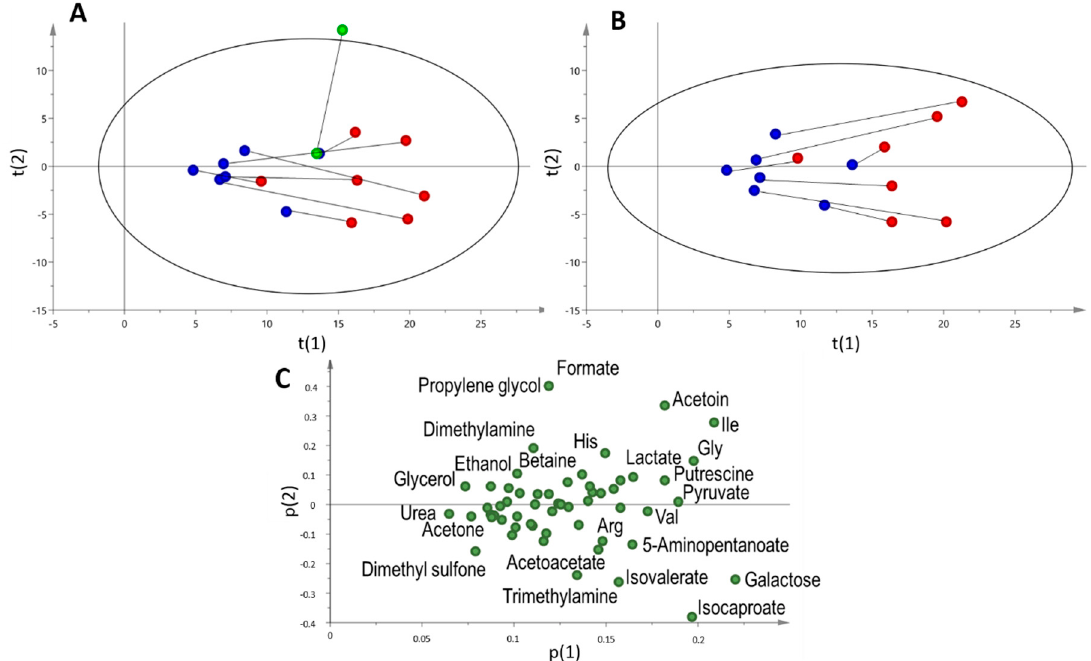
Figure 4. Principal component analysis (PCA) analysis of players belonging to the game group. ( A ) The score plot of pre- (blue) and post- samples (red) for field players. The lines connect the pre- and post-samples for each subject. Goalkeeper samples are depicted in green R 2 X = 0.895, Q 2 = 0.699. ( B ) and ( C ) The score and loading plots of the game group excluding the goalkeeper. R 2 X = 0.907, Q 2 = 0.715.